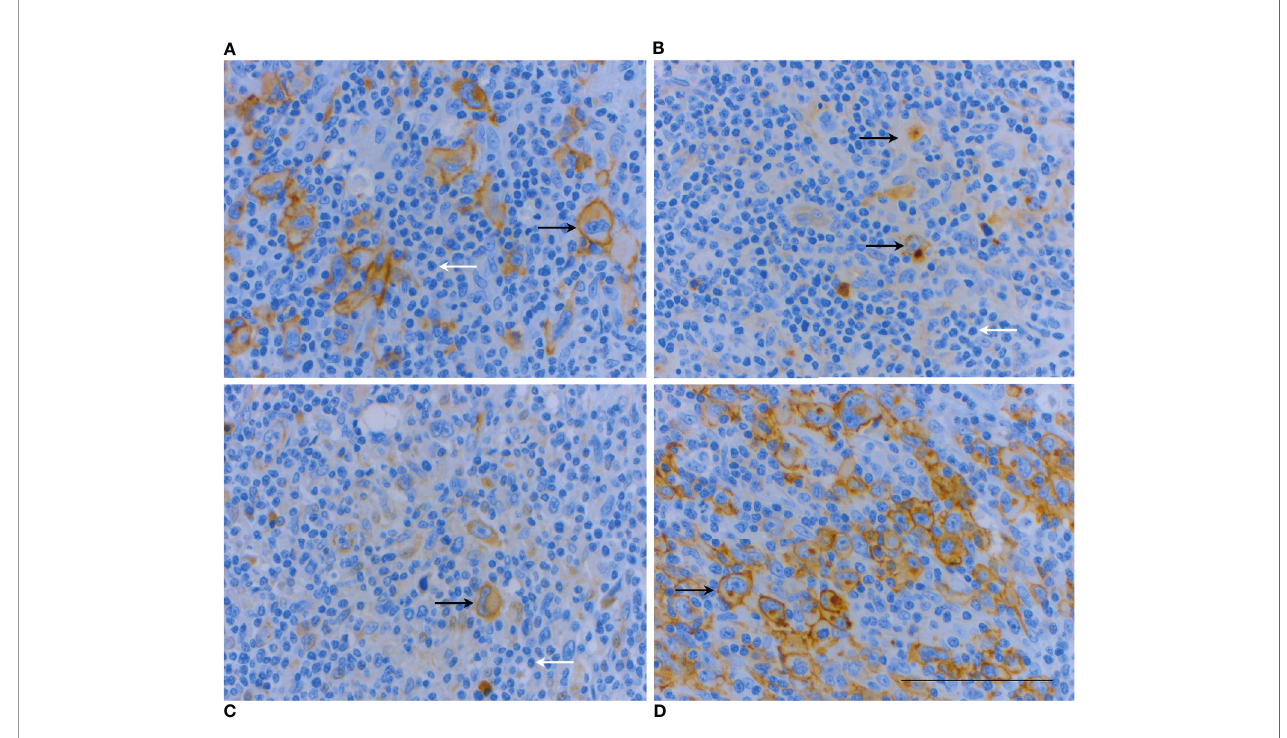
FIGURE 4 | IHC analysis of a patient with HL mixed cellularity subtype (no. 50) shows co-expression of all studied receptors in various cell compartments. SSTR2 IHC (A) is strongly positive (score 3) on the cell membrane of Reed-Sternberg and Hodgkin cells (arrows). SSTR3 IHC (B) and SSTR5 IHC (C) are mildly positive (score 1) in the cytoplasm of the malignant cells (arrows). The most extensive receptor expression is with CXCR4 where IHC showed strong immunopositivity on the cell membrane and cytoplasm of 90% of the malignant cells (D) . Note weak or absent expression of all receptors in most non-neoplastic cells, including reactive small lymphocytes (white arrows). Scale bar=100